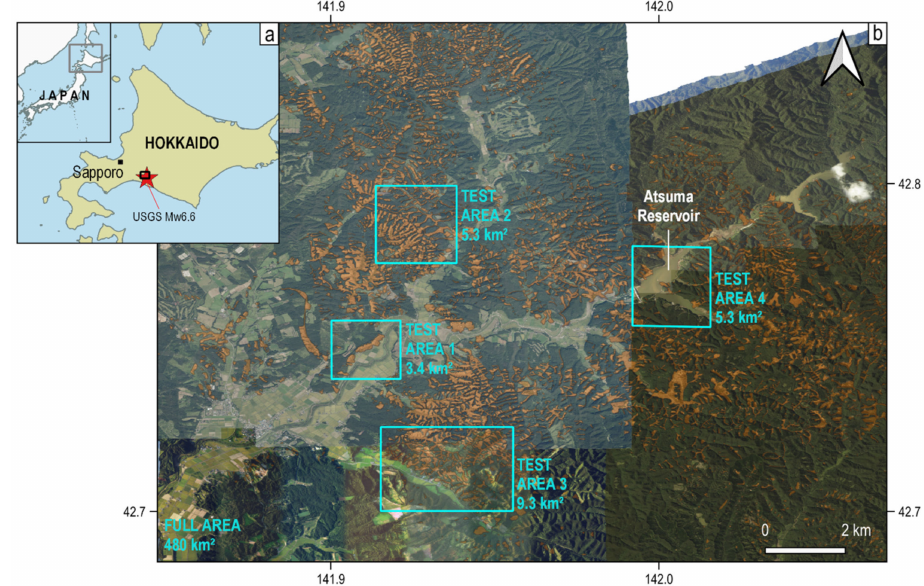
Figure 3. Distribution of earthquake-triggered landslides in Hokkaido, after the 6 September 2018 Mw. 6.6 Hokkaido Easter Iburi Earthquake. Red star in ( a ) represents the epicenter; black box represents the full extent of AOI in ( b ). Background images are aerial photos taken on 6 and 11 September by GSI. Orange polygons are the manually identified landslide patches based on these aerial photos (source: https://www.gsi.go.jp/common/000204728.zip, accessed on 10 March